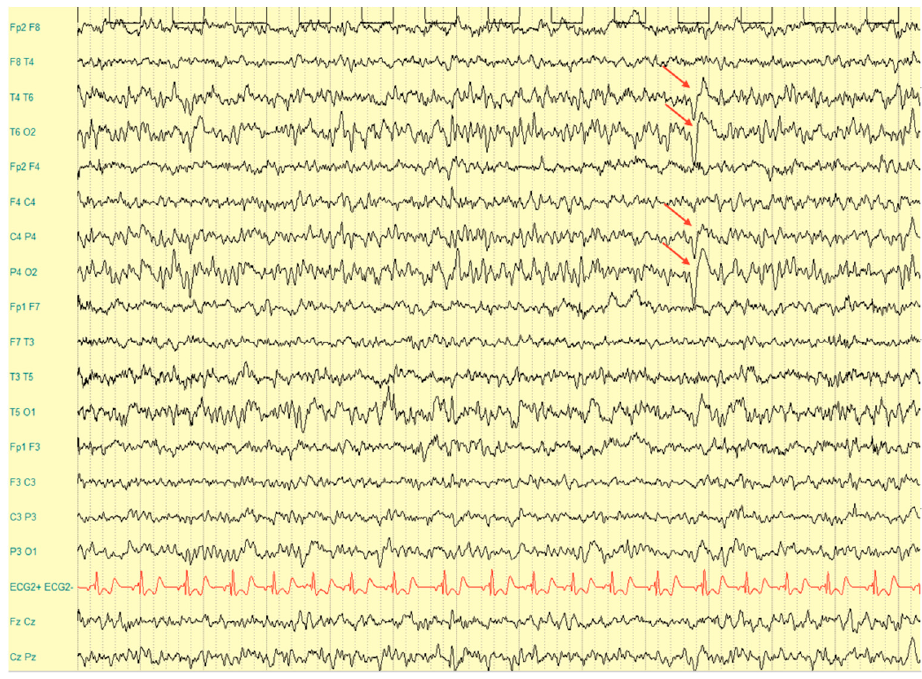
Figure 1. EEG recording showing slow and sharp waves in the temporal, parietal, and occipital regions prevalent on the right side.